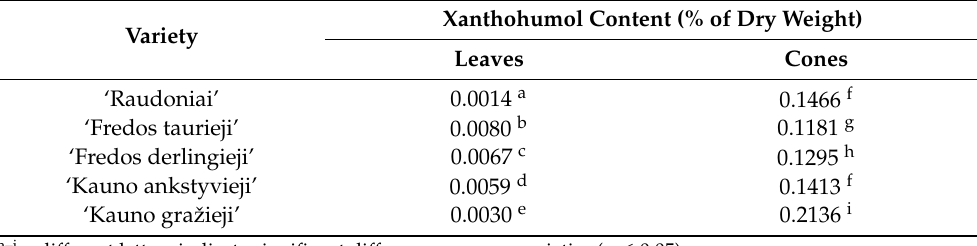
Table 3. Xanthohumol content (% of dry weight) in leaves and cones of Lithuanian hop varieties (RSD ≤ 3.8%, n = 3). Xanthohumol Content (% of Dry Weight) Variety Leaves Cones ‘Raudoniai’ 0.0014 a 0.1466 f ‘Fredos taurieji’ 0.0080 b 0.1181 g ‘Fredos derlingieji’ 0.0067 c 0.1295 h ‘Kauno ankstyvieji’ 0.0059 d 0.1413 f ‘Kauno gražieji’ 0.0030 e 0.2136